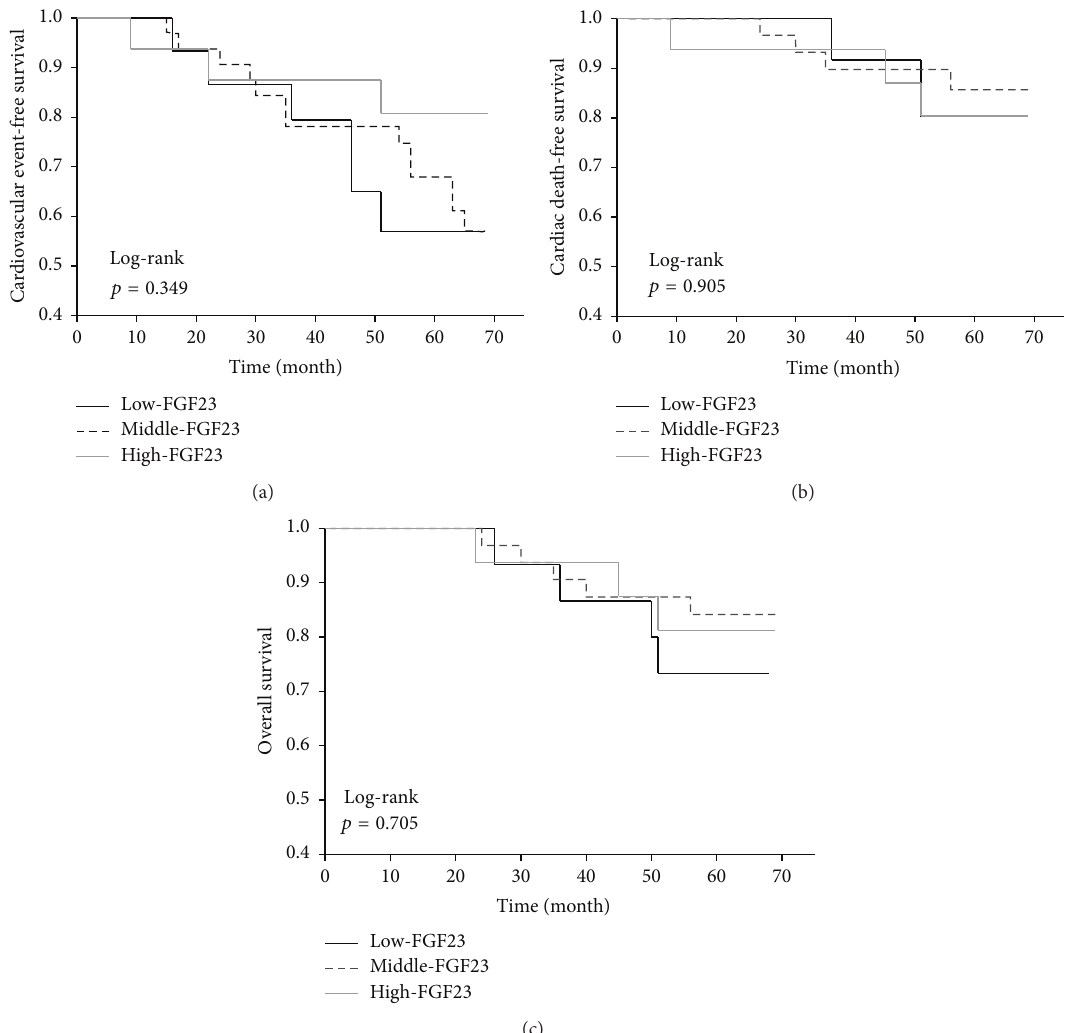
Figure 3: Significance of the serum FGF23 levels with respect to cardiovascular event-free survival (a), cardiovascular mortality (b), and cumulative survival (c). The patients were categorized into low-FGF23 ( < 1184pg/mL), middle-FGF23 (1184 to < 15134 pg/mL), and high- FGF23 ( ≥ 15134pg/mL) groups. The Kaplan-Meier analysis with the log-rank test failed to demonstrate any significant differences between the